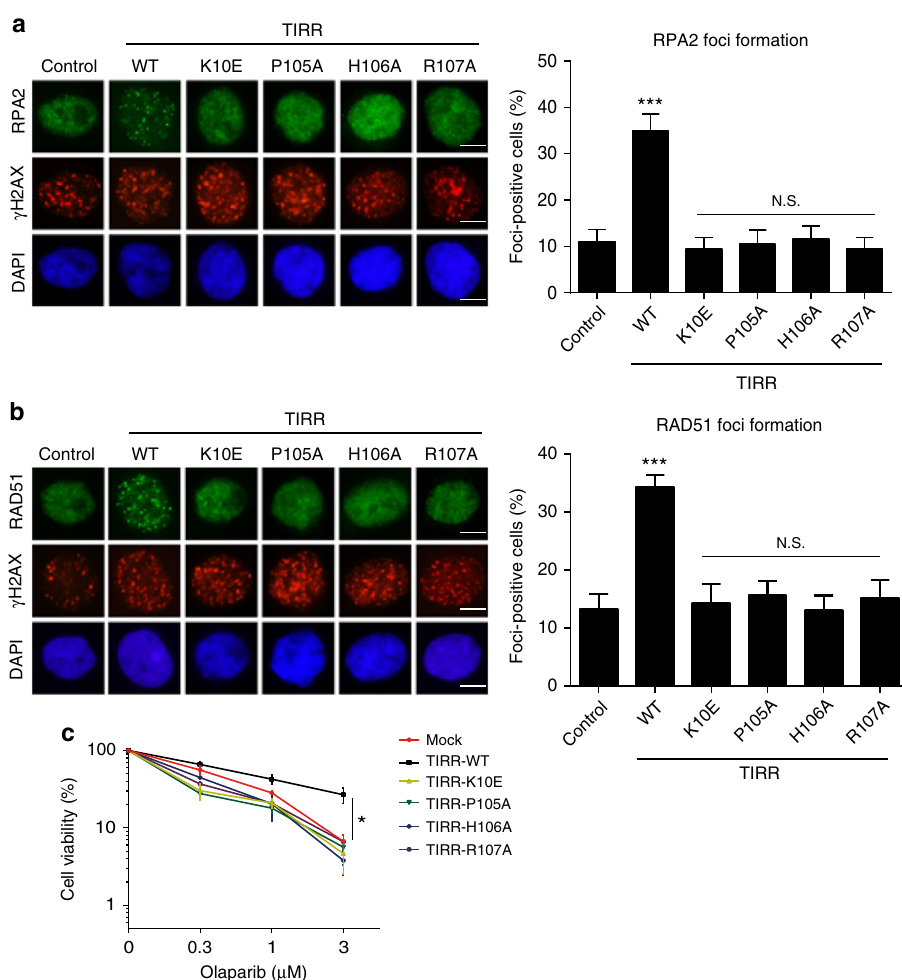
Fig. 5 TIRR regulates DSB repair in the BRCA1-de fi cient cells. Wild-type TIRR or its mutants were expressed in UWB1 (BRCA1-de fi cient) cells. The cells were treated with 10 Gy of IR. The IRIF of RPA ( a ) or RAD51 ( b ) was examined by immuno fl uorescence staining. Alternatively, the cells were treated with indicated dose of olaparib (PARP inhibitor) for 6 days. Scale bar represents 5 µ m. Cell viability was examined ( c ). Data are represented as mean ± s.d. as indicated from three independent experiments. N.S.: non signi fi cant; *: statistically signi fi cant ( p < 0.05); ***: statistically signi fi cant ( p < 0.001). Scale bar represents 5 µ